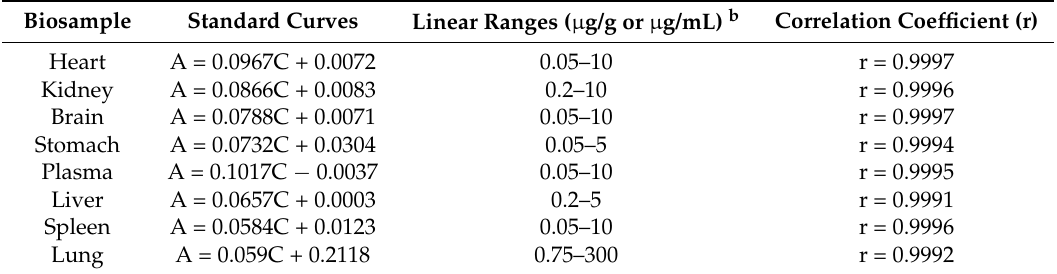
Table 1. Linear ranges, standard curves and correlation coefficients of baicalin in different rabbit